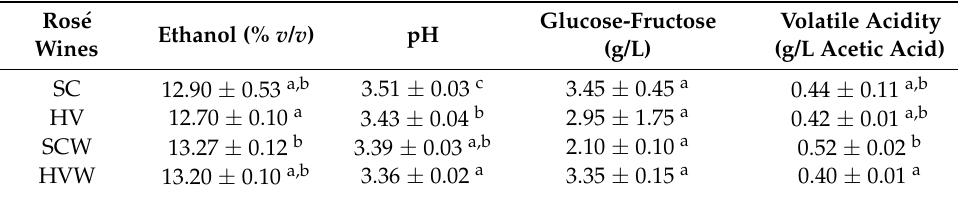
Table 1. General oenological parameters in ros é wines measured by